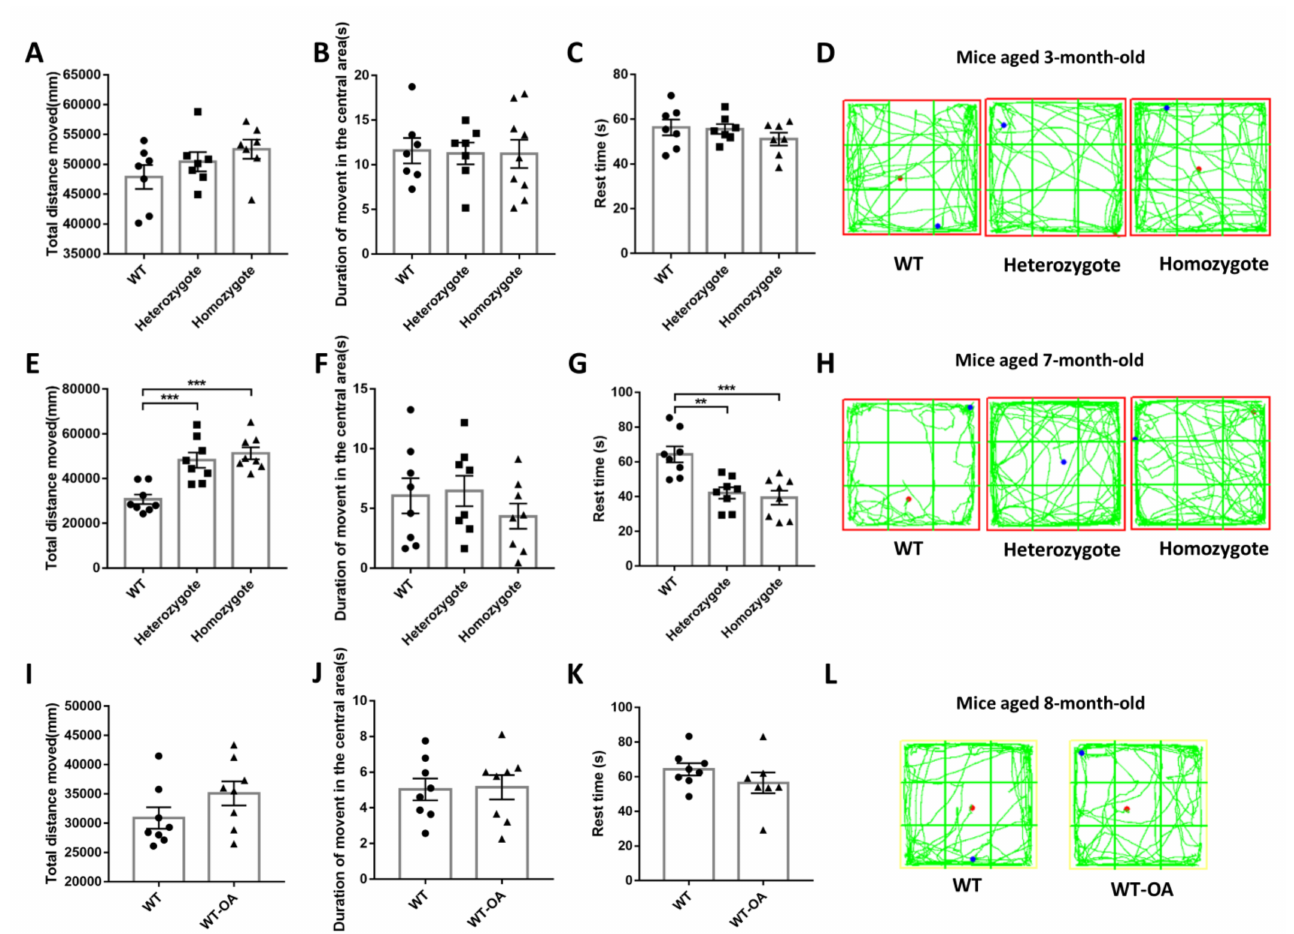
Figure 7. The open field test of 3-month-old, 7-month-old and 8-month-old mice showed that inhibition of BChE enzyme activity rescued the age-related vitality decline. ( A – D ) The open field test of 3-month-old WT and BChE KO mice. The total distance, duration of movement in the central area, rest time and representative trajectory diagram were shown. ( E – H ) The open field test of 7-month-old WT and BChE KO mice. ( I – L ) The open field test of 8-month-old WT mice administered ( R )-bambuterol through oral route. Data were represented as mean ± SEM. n = 7–9 mice per group. ** p < 0.01; *** p < 0.001, one-way ANOVA followed by Tukey’s post hoc test (for A – C , E – G ) and unpaired t test (for I – K